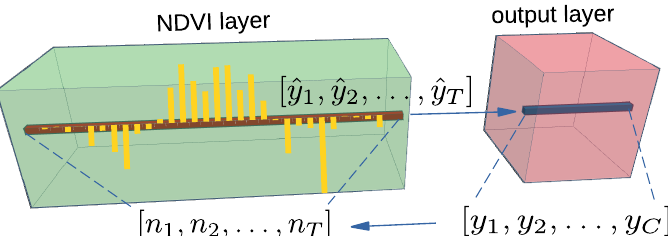
Figure 5. Schematic representation of the last two layers of the neural model involved in the computation of the Class Activation Intervals. Starting from the aggregate features [ ˆ y 1 , . . . , ˆ y T ] it is possible to obtain the vector of activations [ y 1 , . . . , y C ] to determine the class associated with a pixel and vice versa, it is possible to obtain the Class Activation Intervals [ n 1 , . . . , n T ] starting from the values [ y 1 , . . . , y C ] .